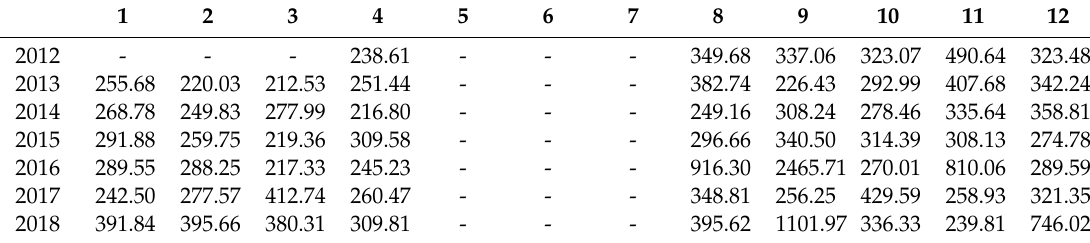
Table A1. Upper limit of nighttime thresholds for each month from 2012 to 2018.